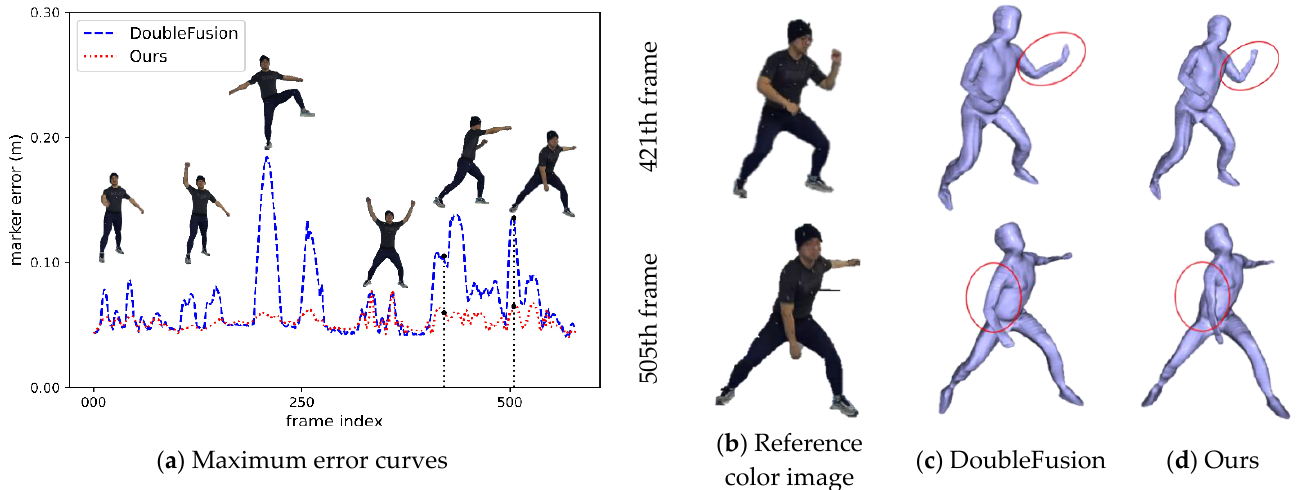
Figure 8. Results of motion tracking. Table 1. Maximum instant errors on the entire sequence of each joint.